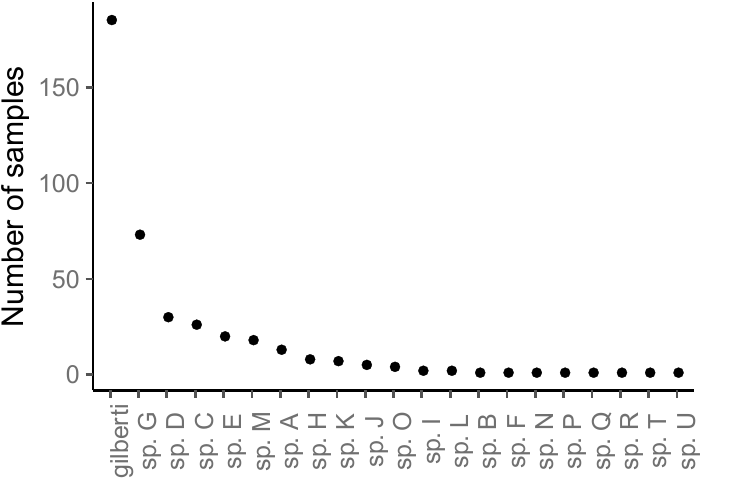
Figure 11. Ranked abundance as total number of samples for each species from pooled data for all survey sites across five subregions in the Australian Wet Tropics.